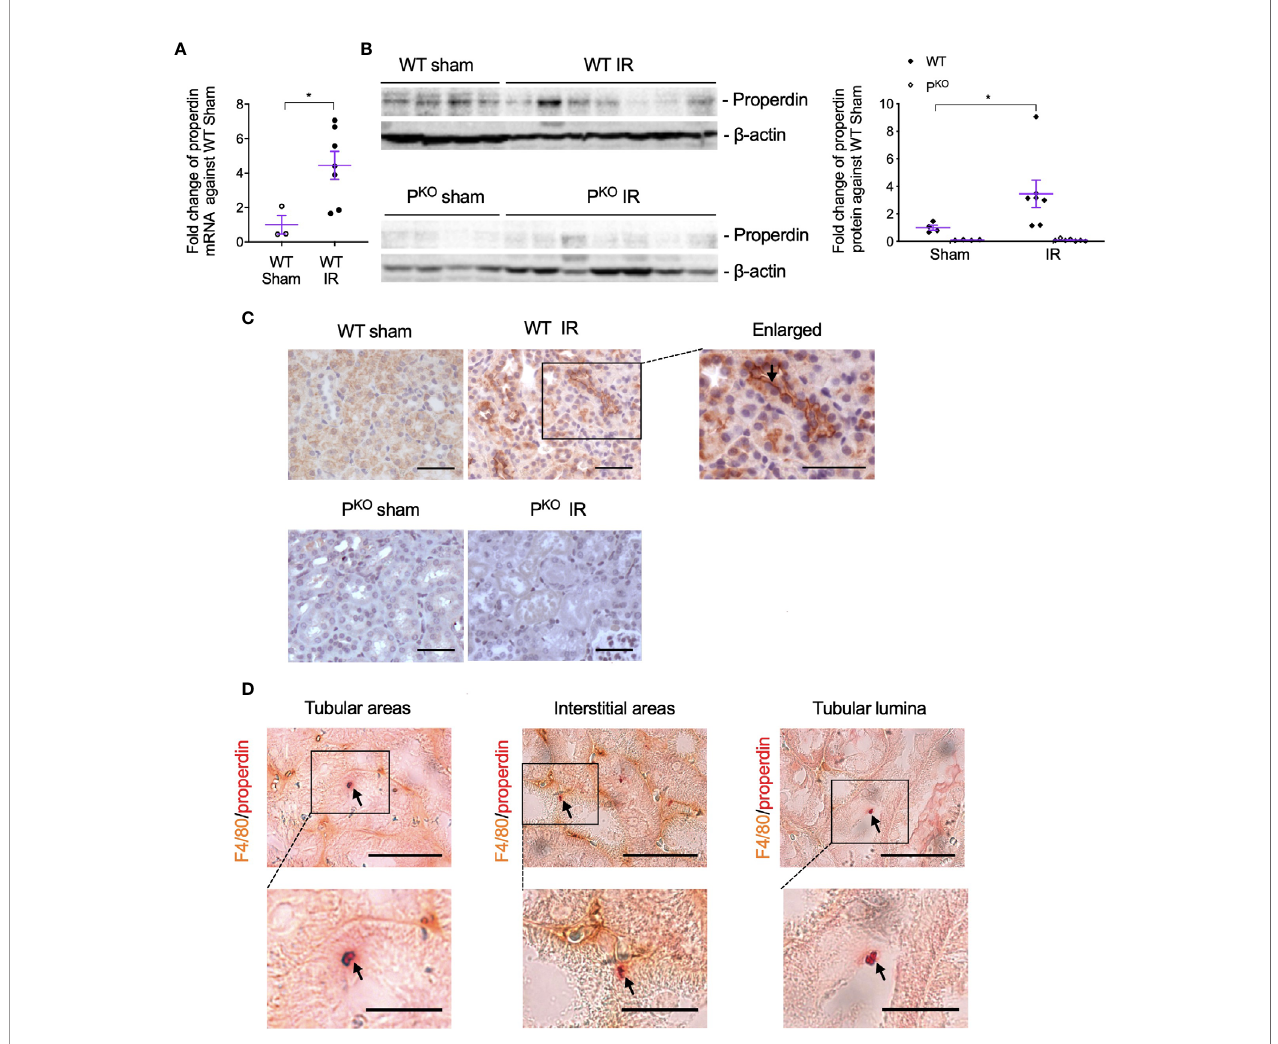
FIGURE 5 | Properdin expression and localization in kidneys post IR at 72 h, as well as its co localization with F4/80+ macrophages. (A) The expression of properdin mRNA in kidneys analyzed by qPCR was raised by IR in contrast to the sham control in WT mice. (B) The expression of properdin protein in kidney homogenates detected by Western blot was increased by IR in WT mice but was not seen in P KO mice (sham: n = 3 – 4; IR: n = 7). Data were shown as means ± SEMs. Signi fi cance was assessed by unpaired t -test for qPCR result and one-way ANOVA and LSD test for Western blots. * p < 0.05. (C) Representative images of properdin immunostaining in the cortex of WT sham and IR kidneys, with the boxed area enlarged and properdin staining on the apical surface of tubular cells was pointed by an arrow. All scale bar represent 50 m m. (D) Properdin and F4/80 double-stained cells were visualized in tubular areas, interstitial areas, and tubular lumina (pointed by arrows), with the boxed area enlarged. Most of double staining positive cells had typical apoptotic features including reduced cell volume, and the cellular membrane becoming ruf fl ing and blebbing were also shown. Scale bar: 50 m m (upper row) and 20 m m (lower